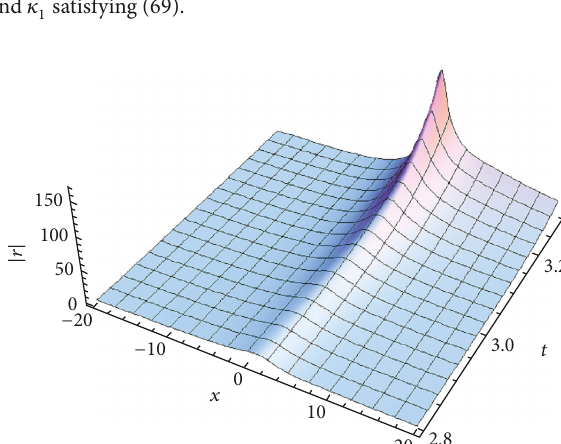
Figure 1: Local spatial structure of one-soliton solution (67) with 𝜅 1 and 𝜅 1 satisfying (69).